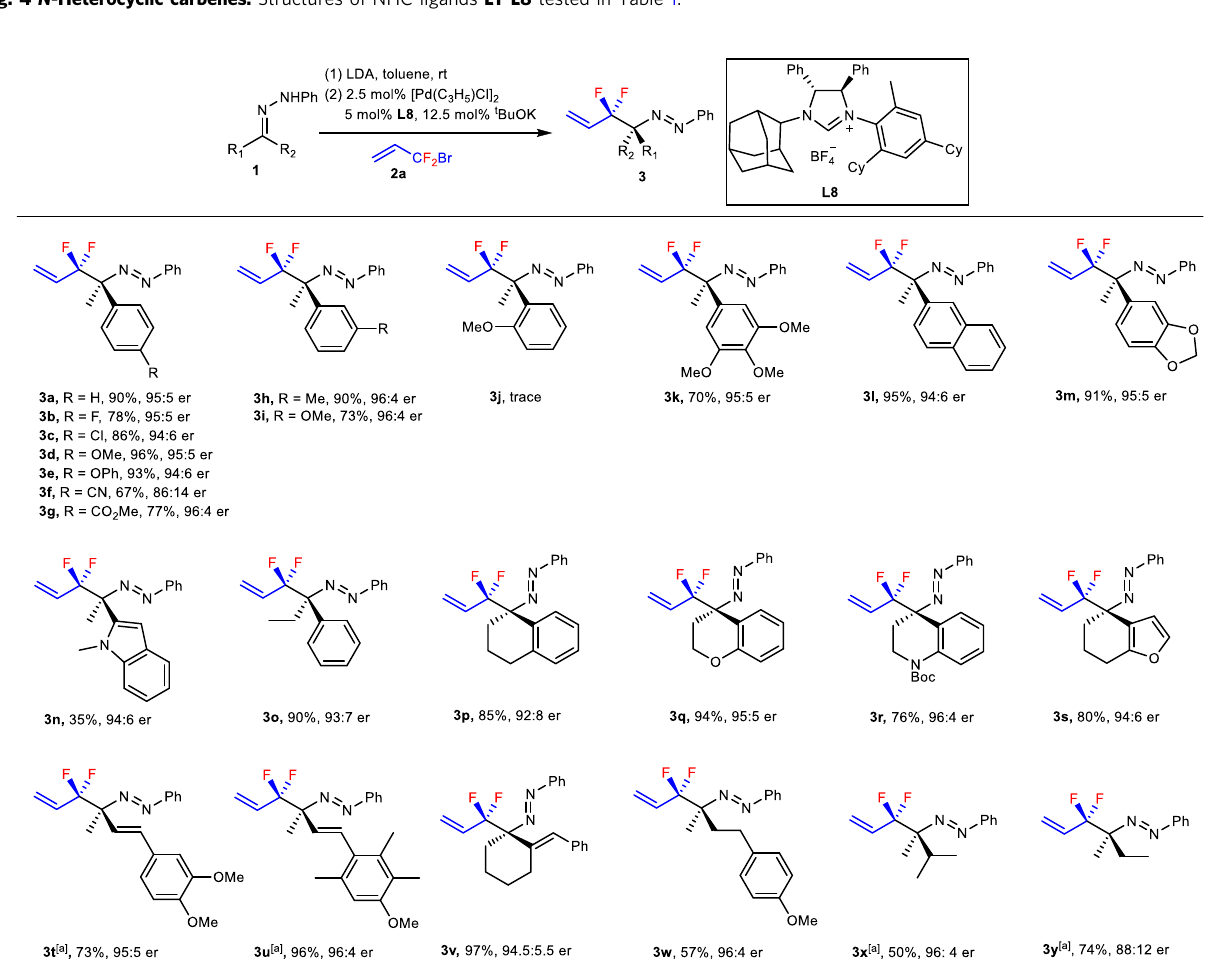
Fig. 5 Substrate scope of Pd-catalyzed asymmetric umpolung di fl uoroallylation of different hydrazones 1 with allyl reagent 2a. Reaction conditions: 1 / LDA/ 2a /[Pd(C 3 H 5 )Cl] 2 / L8 = 200/200/100/2.5/5; 0.05 M of 2a ; 3/4/5 ratio was determined by 19 F NMR of crude products, tri fl uoromethylbenzene as the internal standard; yield was the isolated yields for 3 ; er value was determined by chiral HPLC. [a] Ran at 10 °C.